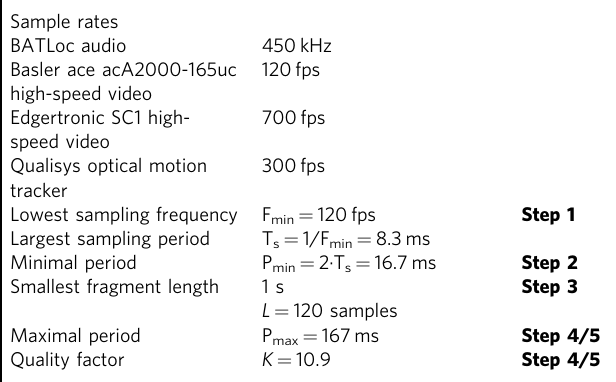
Table 1 This table shows the devices and their sample rates in our experimental setup as well as the values used by the algorithm in Box